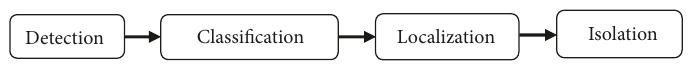
Figure 10: Work fl ow diagram of PV array FMS.